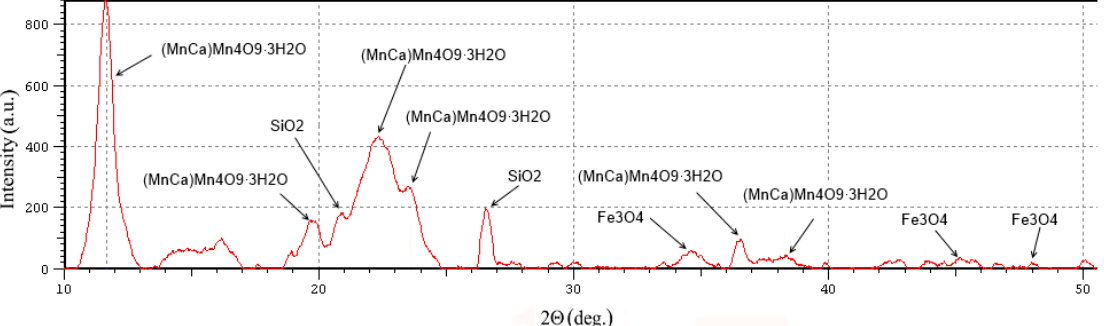
Figure 1. Results of X-ray phase analysis of the initial ore samples.